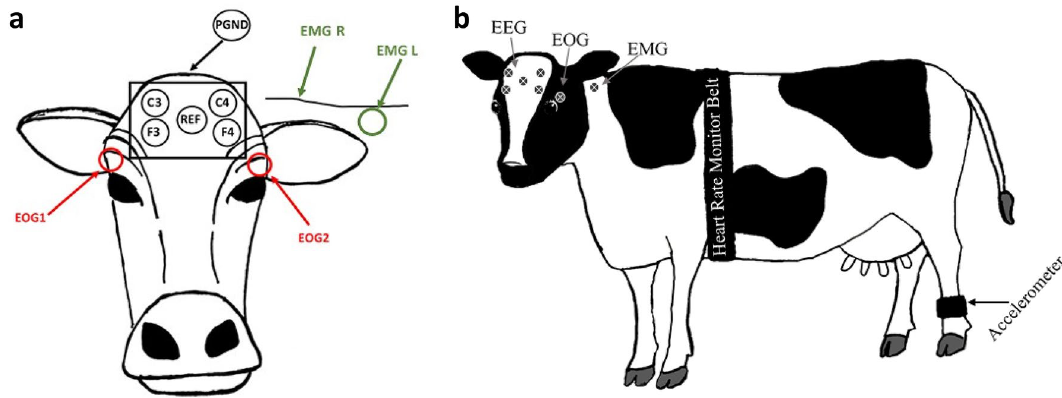
Figure 3. ( a ) Diagram indicating electrode placement on the head and neck of the cow for PSG data acquisition. Four EEG electrodes (C3, C4, F3 & F4) and a reference (REF) electrode were placed on the forehead. PGND- patient grounding electrode was placed behind the poll on the top of the head. Two EOG electrodes were placed beside the eyes and two EMG electrodes were placed on the mid-trapezius muscle on either side of the neck. ( b ) Diagram indicating placement of the heart rate monitoring girth strap, leg mounted accelerometer, and PSG electrodes on the whole